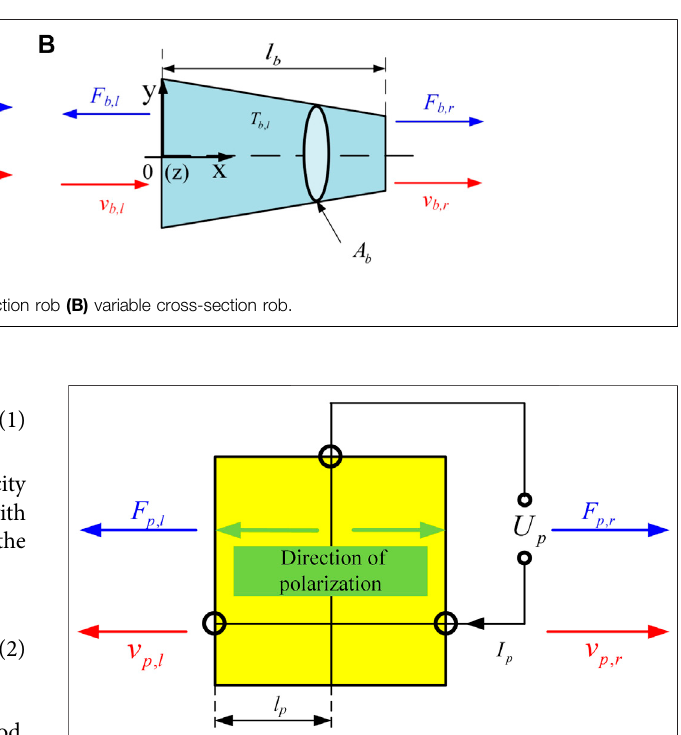
FIGURE 6 | Longitudinal vibration of piezoelectric